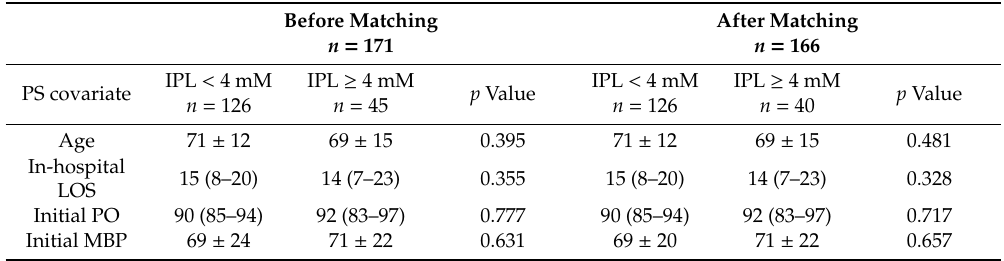
Table 4. Comparison of variables for 30-day mortality included in the propensity score before and after matching.